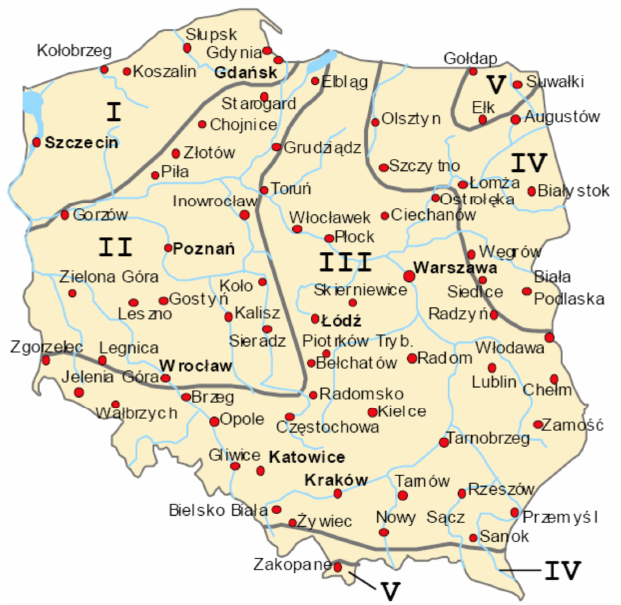
Figure 1. Poland divided into five climatic zones [24]. Table 2. Information on the climatic conditions in the analyzed localizations [24].